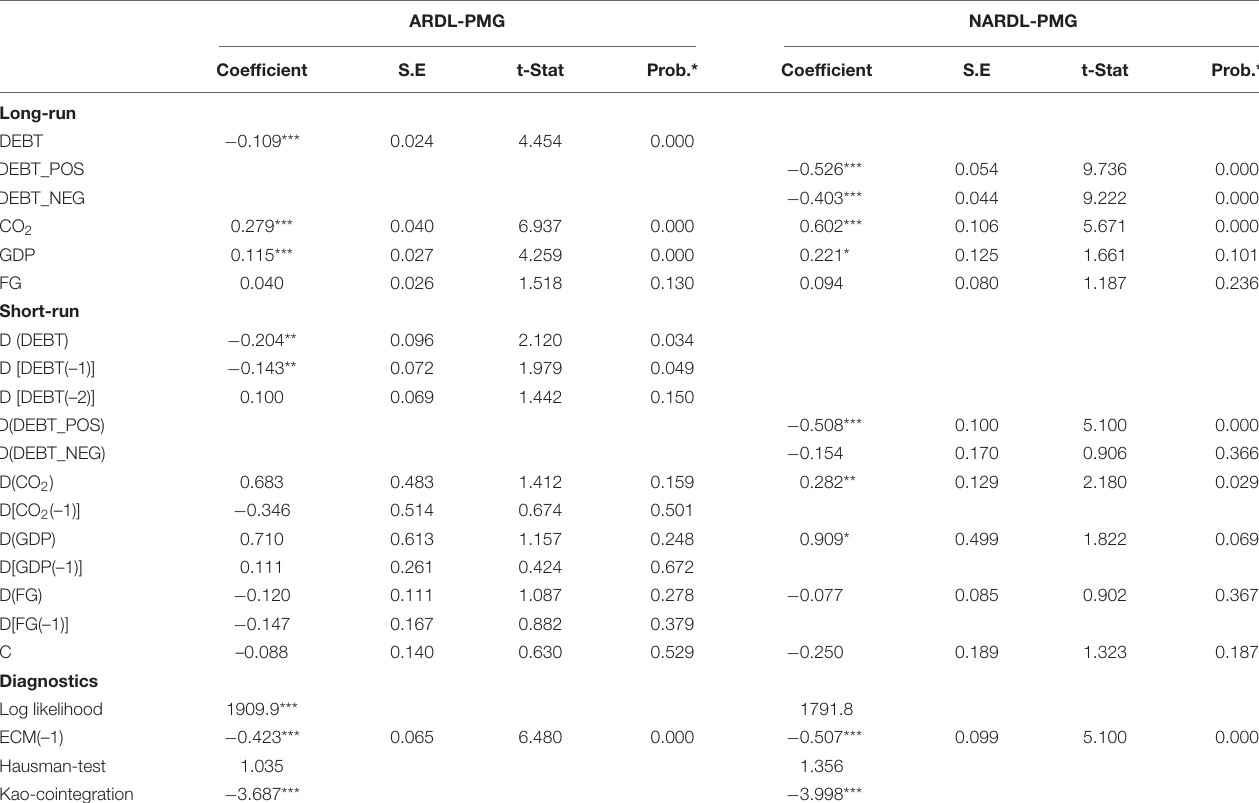
TABLE 4 | Results of ARDL-PMG and